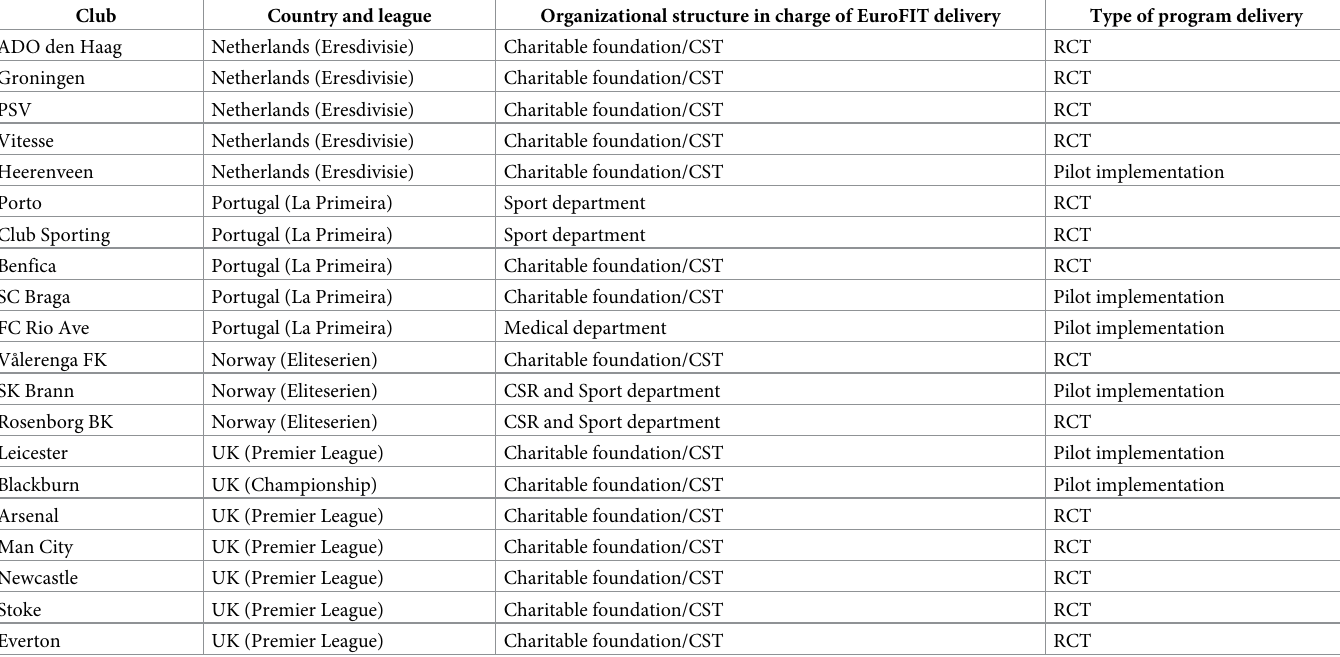
Table 1. Clubs involved in the EuroFIT RCT or pilot implementation delivery.